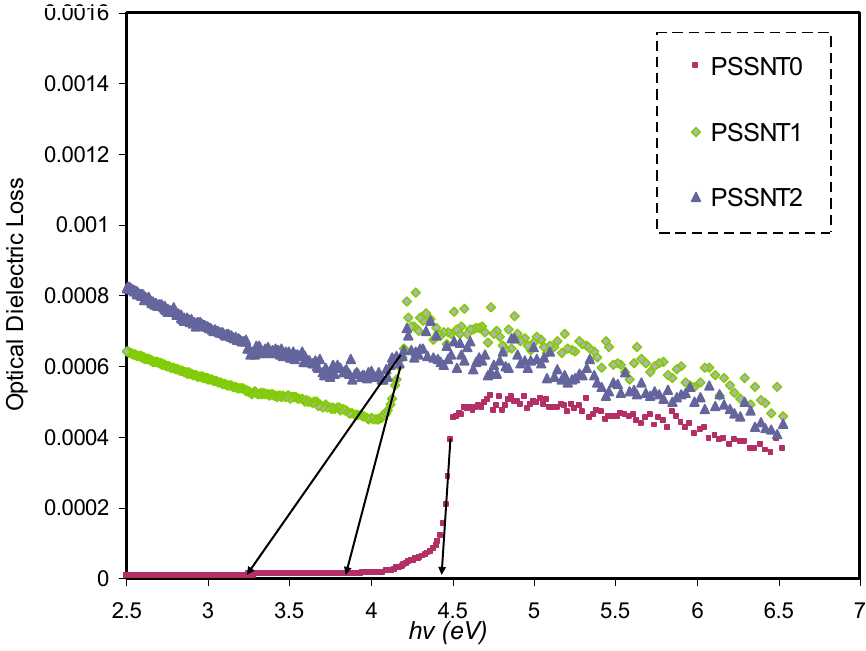
Figure 7. The optical dielectric loss ( ε″ ) spectra versus photon energy for pure PS (PSSNT0), PSSNT1, and PSSNT2 composite films.